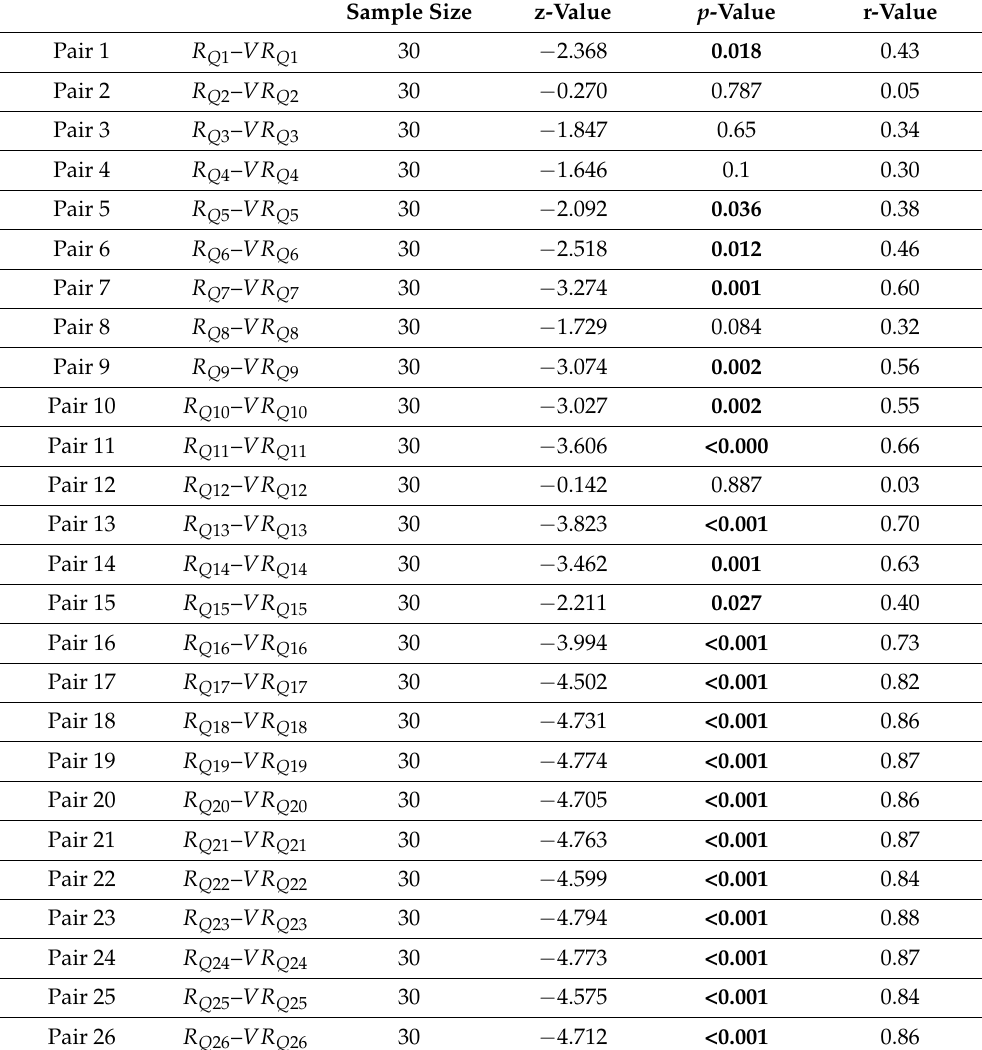
Table 1. Summary of hypothesis testing: Wilcoxon Signed-Rank